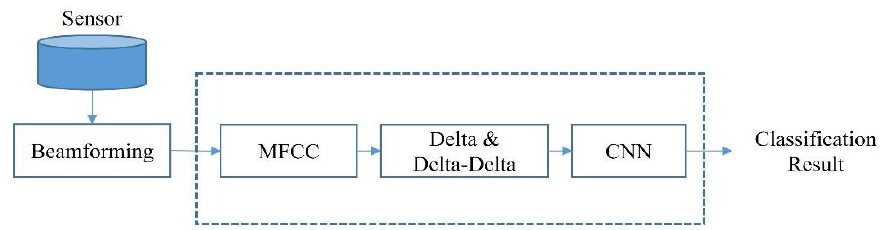
Figure 5. The classification diagram for comparison considering MFCC as baseline.